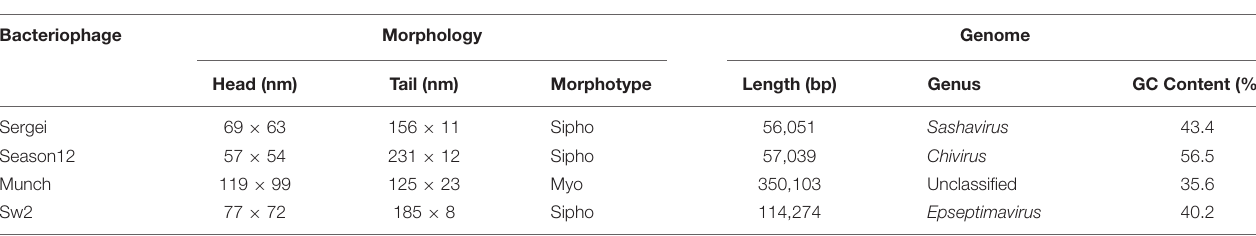
TABLE 1 | Phage virion dimension and general genome characteristics.